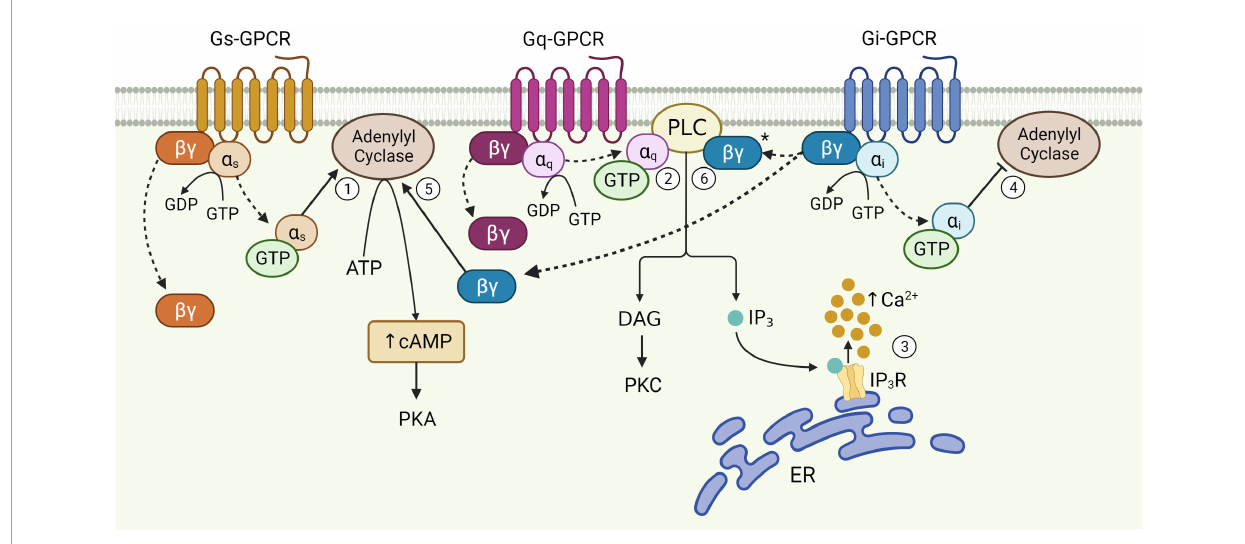
FIGURE1 Schematic of astrocytic G-protein coupled receptor (GPCR) signaling. Activation of membrane-bound astrocytic GPCRs triggers the exchange of GDP for GTP at the α subunit and dissociation of α and βγ subunits from the receptor (dotted arrows). Once released, α s stimulates adenylyl cyclase activity leading to the production of cAMP from ATP (1). α q binds PLC, catalyzing diacylglycerol (DAG) and IP 3 synthesis (2). IP 3 binds its receptor on the endoplasmic reticulum (ER) to release Ca 2 + from internal stores (3). α i inhibits adenylyl cyclase activity (4). The Gi βγ subunit can potentiate cAMP elevations mediated by Gs-GPCRs (5), and is speculated to enhance Gq-GPCR-mediated Ca 2 + release from stores via the PLC-IP 3 pathway (6), although this has yet to be proven in astrocytes (*). Figure created with